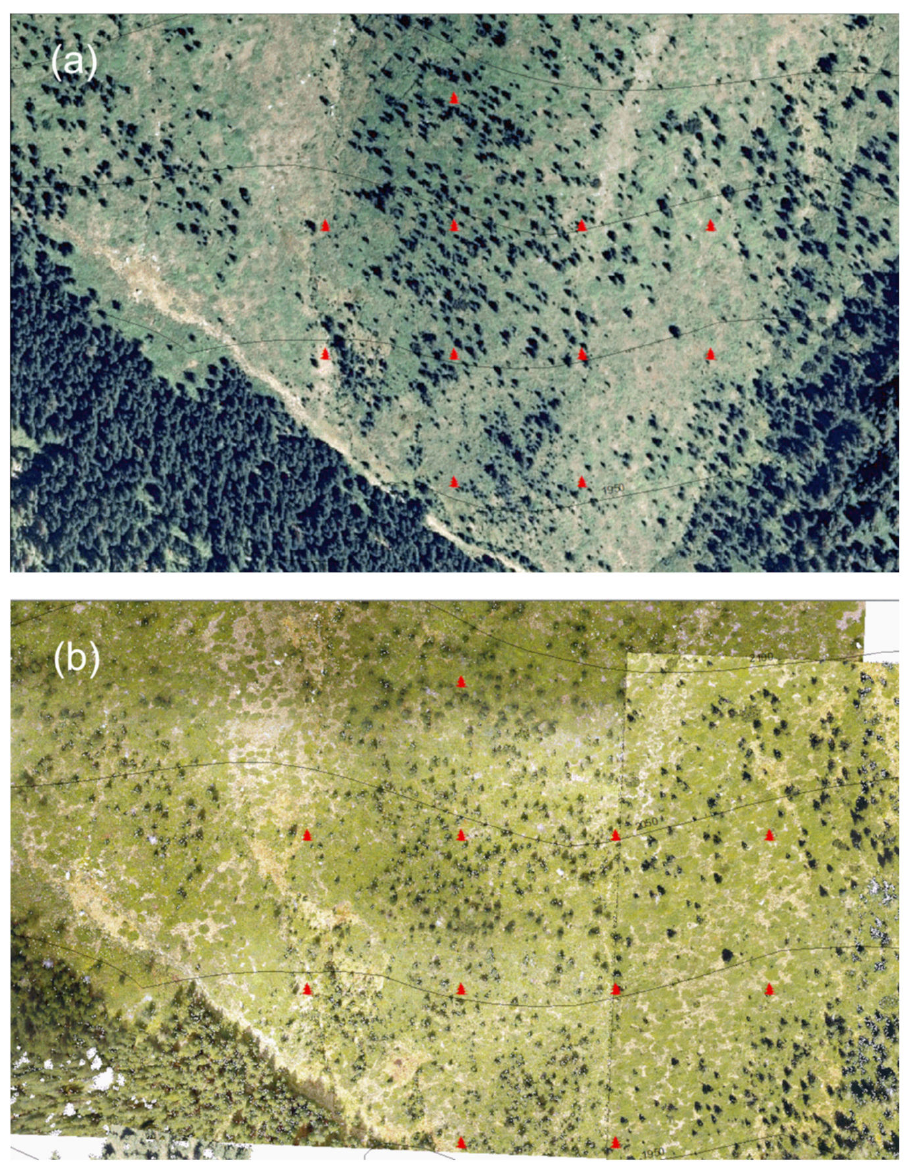
Figure 9. Cross-verification of ecosystem extent change detection in the upper ecotone—succession from grasslands through shrubs to coniferous forests. Verification of Copernicus HRL change in tree cover density (red pixel centroids represent increase in tree cover density between the base years 2015 and 2018 at 100 m pixel) as compared to the actual vegetation cover in ( a ) ortho-photography (2011), and ( b ) our georeferenced drone imagery (2016). The northernmost and southernmost of these centroids are outside the scope of the 2016 forestry database, whereas the remaining are within a polygon of the coniferous ecosystem